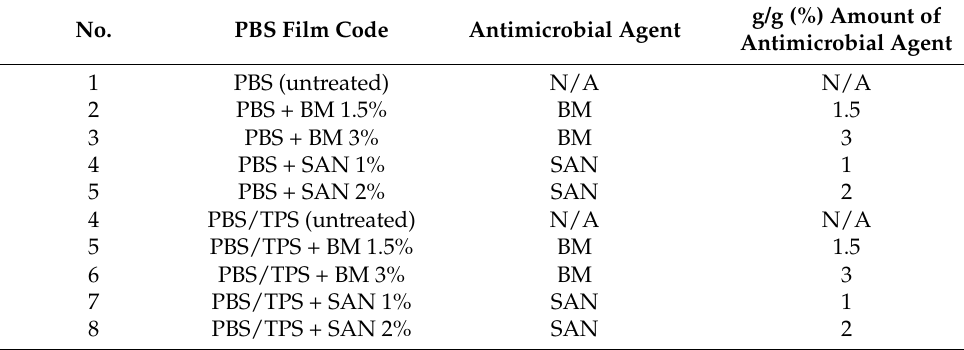
Table 1. A total of 10 formulations of PBS